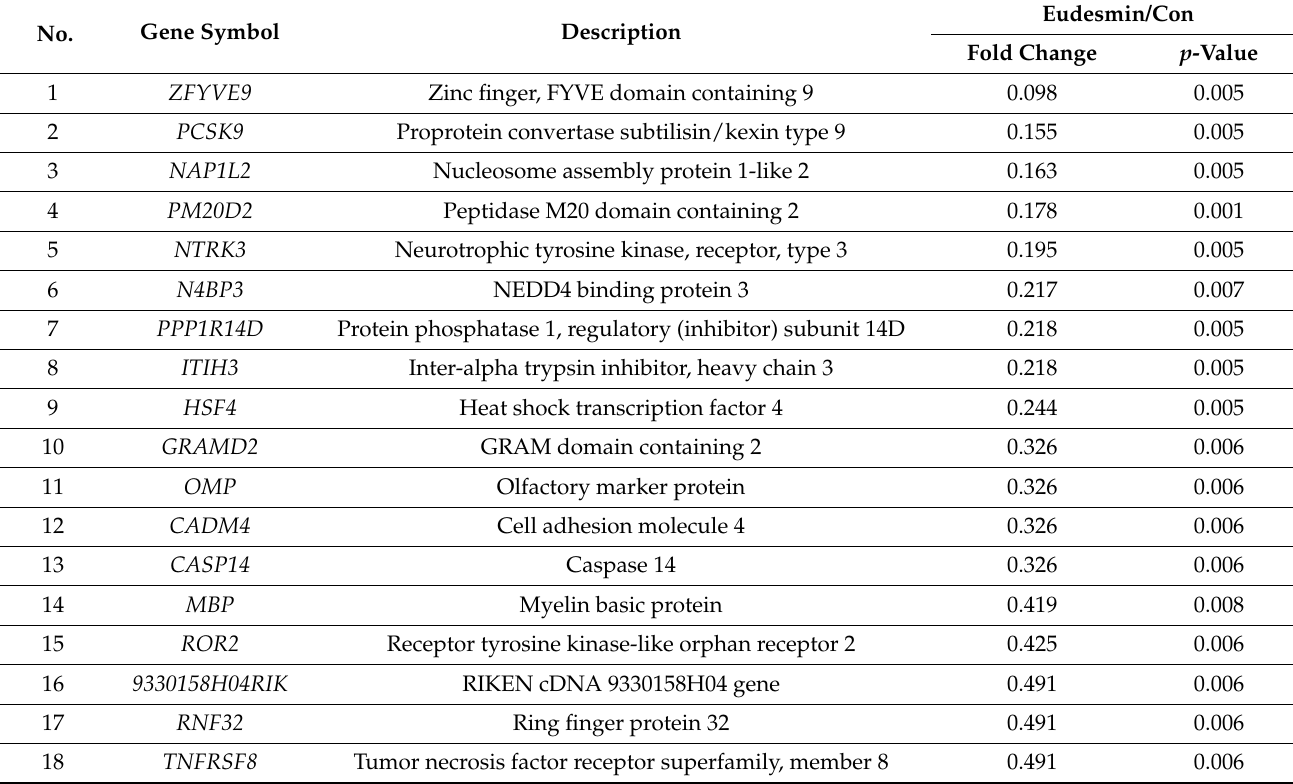
Table 2. PRC2 target genes downregulated by eudesmin (Cluster